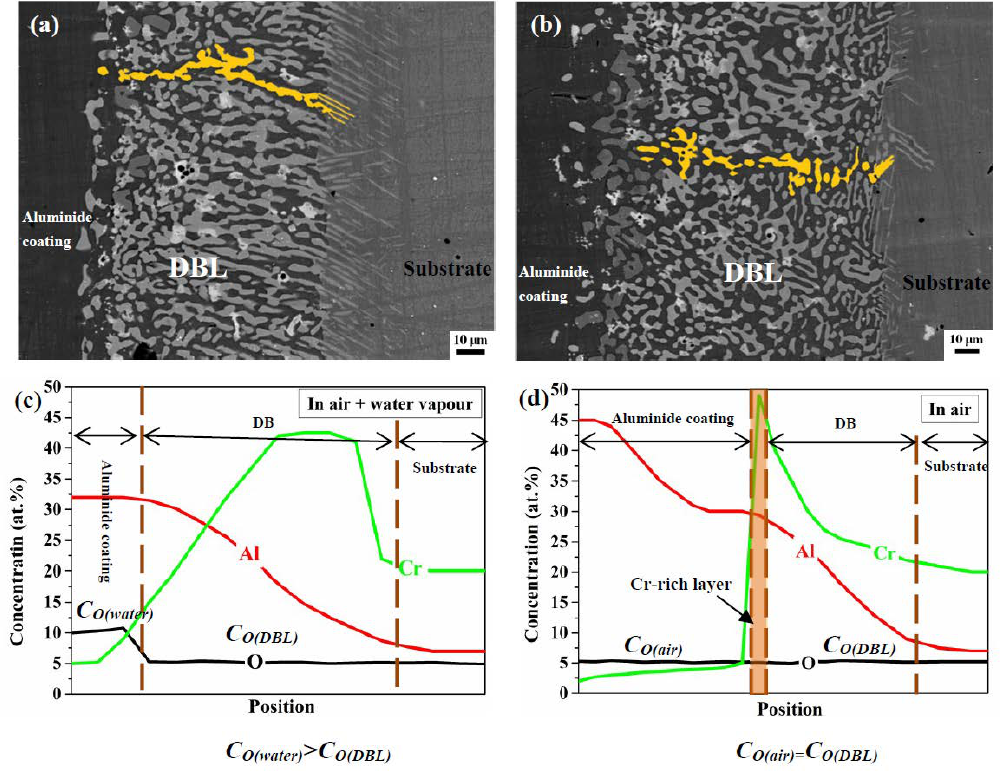
Figure 8. Micrograph of interdiffusion zone oxidized at 1050 °C for 150 h: ( a ) in air plus water vapour and ( b ) in air; schematic of the elemental content of the interdiffusion zone on an IN738 superalloy after being oxidized for 150 h ( c ) in air plus water vapour and ( d ) in air at 1050 °C.